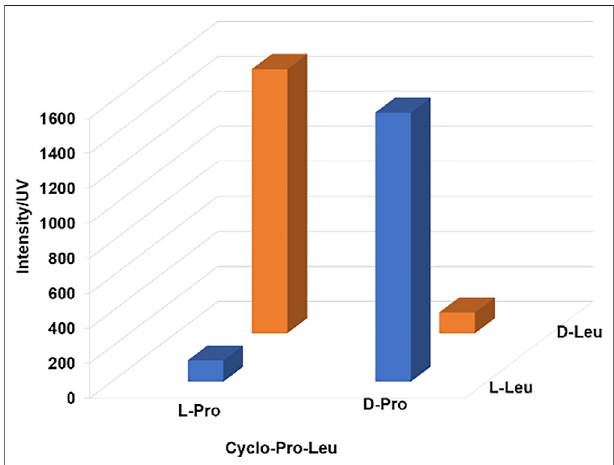
FIGURE 5 | Effect of chirality of Pro and Leu on the cyclo-Pro-Leu formation. These reactions were carried out under standard conditions.